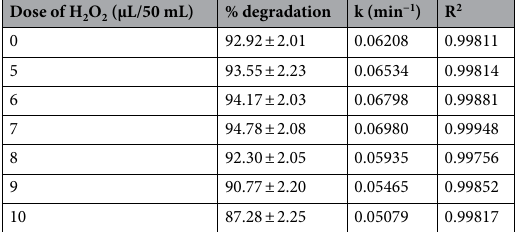
Samples % degradation k (min −1 ) % TOC removal % COD reduction R 2 In 2 O 3 /MoS 2 /Fe 3 O 4 + H 2 O